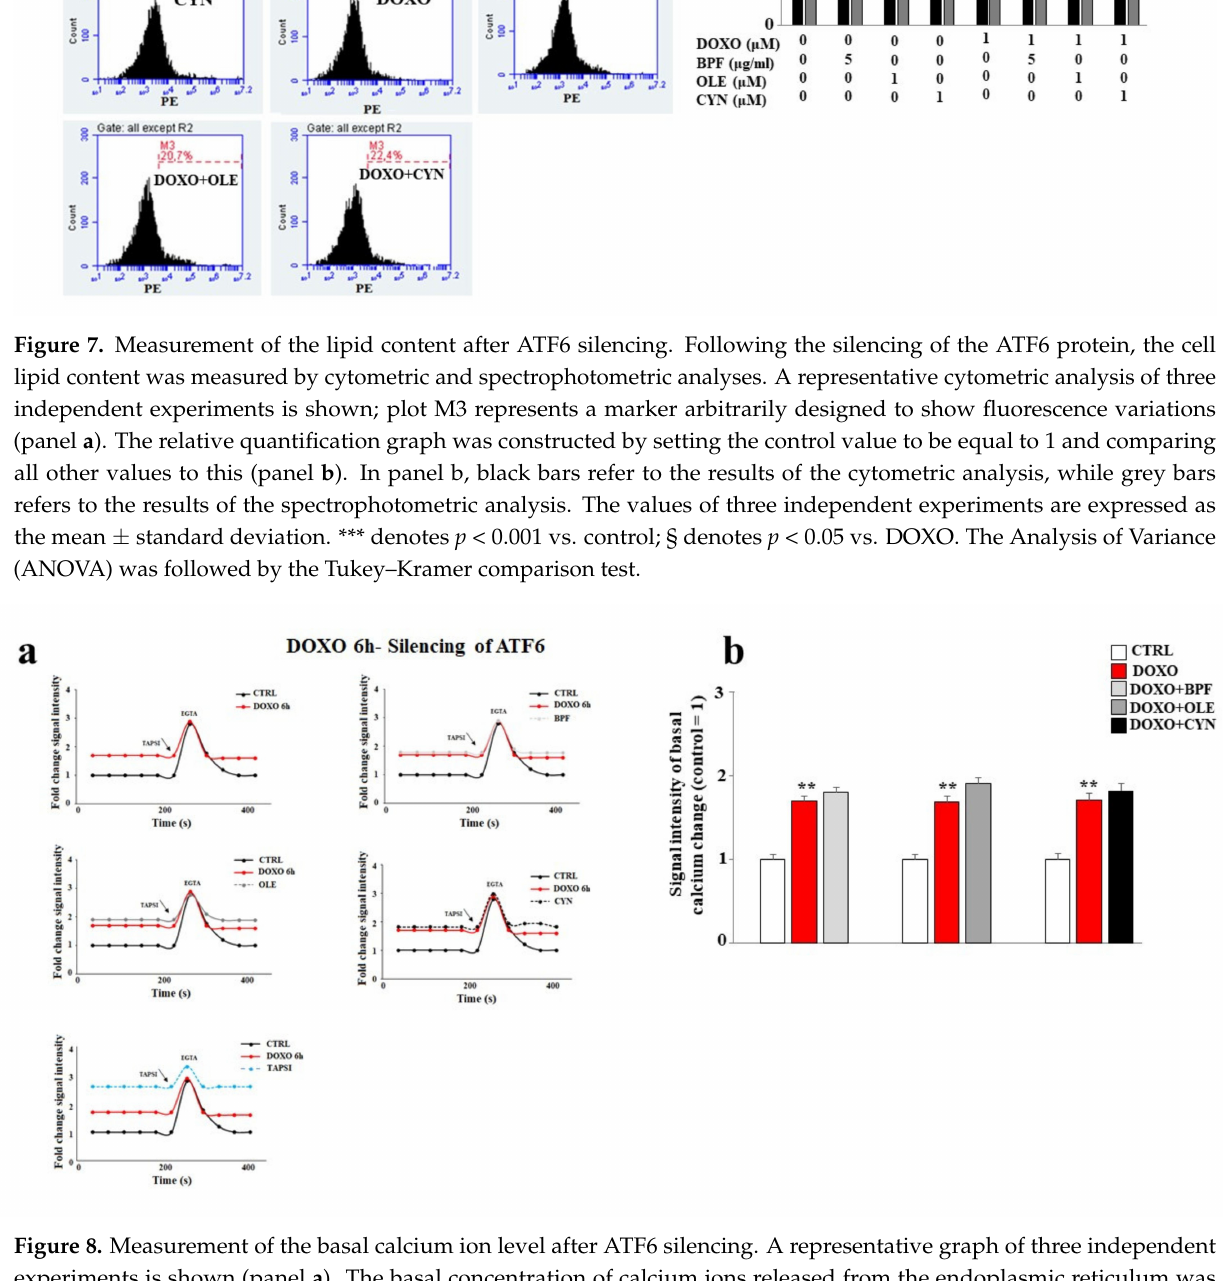
Figure 8. Measurement of the basal calcium ion level after ATF6 silencing. A representative graph of three independent experiments is shown (panel a ). The basal concentration of calcium ions released from the endoplasmic reticulum was measured in cells silenced for ATF6 and treated with 1 µ M DOXO alone for 6 h, or pre-treated with BPF (5 µ g/mL), OLE (1 µ M), or CYN (1 µ M) for 24 h and then exposed to DOXO for 6 h. Cells treated with TAPSI were used as positive controls. Relative quantification of the signal intensity of the basal calcium change was conducted (panel b ). ** denotes p < 0.01 vs. control. The Analysis of Variance (ANOVA) was followed by the Tukey–Kramer comparison